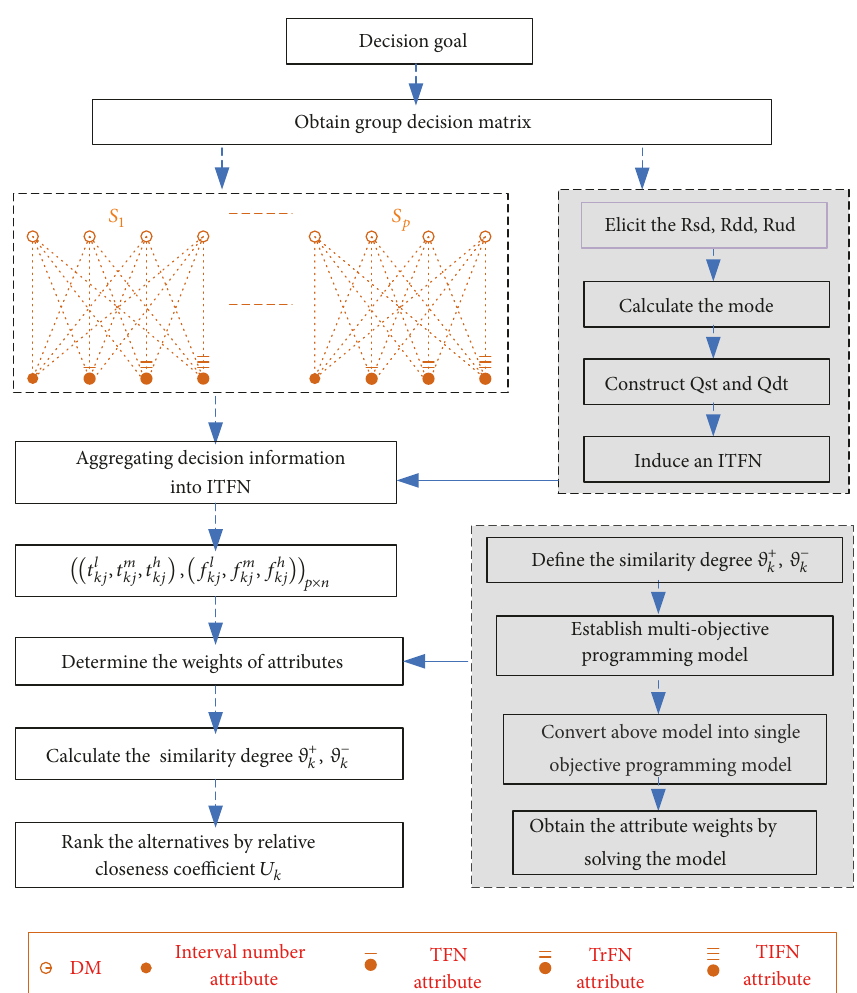
Figure 3: The framework of the proposed heterogeneous MAGDM